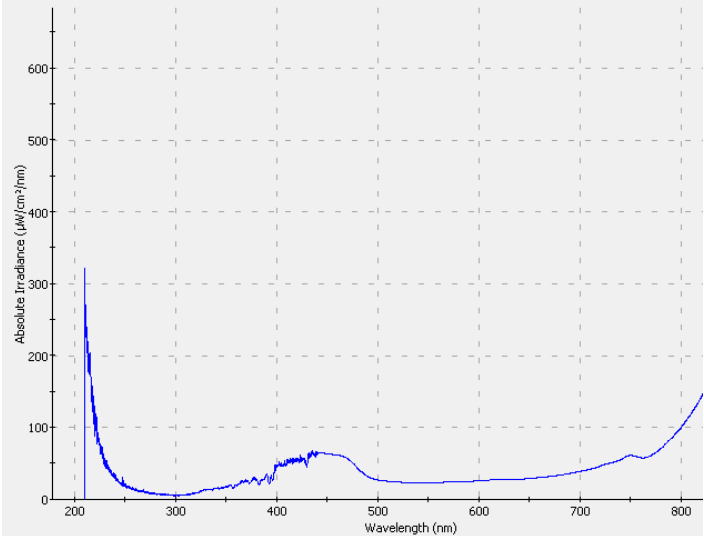
Figure 5. Emission spectrum of sunlight radiation (June 2018; N 40.1865243°, E 8.41797950°).